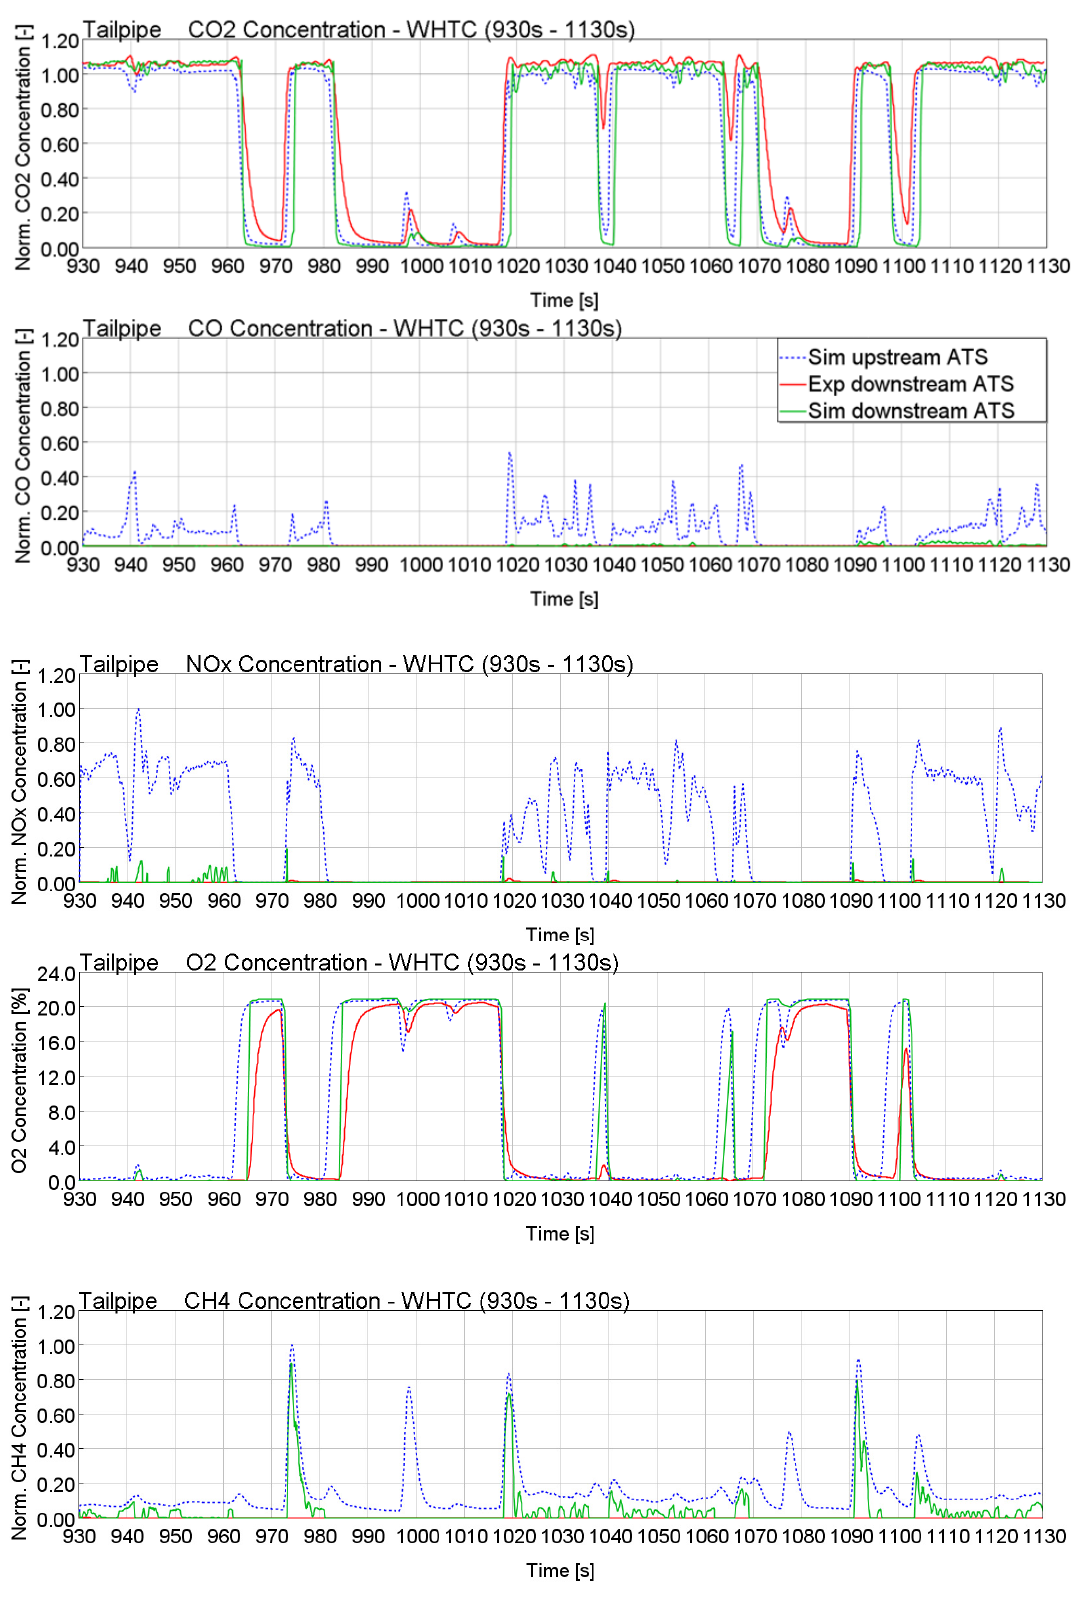
Figure 15. NO, CO, CO 2 , O 2 and CH 4 tailpipe concentrations; comparison between predicted and experimental data during a characteristic timeframe of the WHTC.